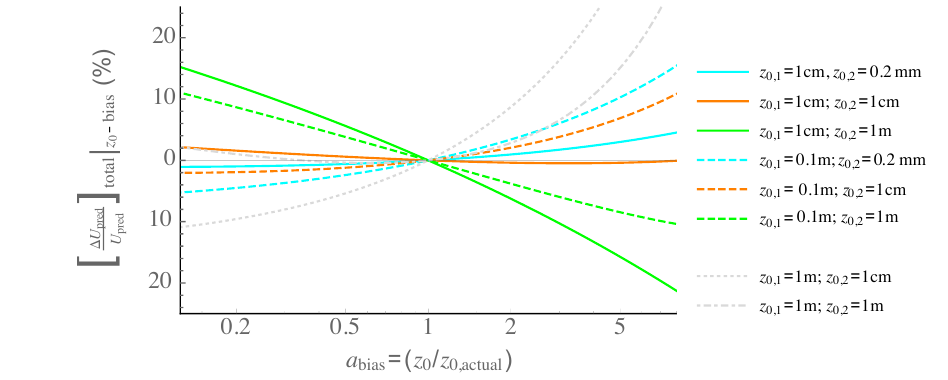
Figure 5. Total error in predicted wind speed due to a bias ( a bias ) in background roughness at both prediction and measurement sites for different combinations of background roughness at the sites. As in Figs. 3–4, observation height is z obs = 60m and prediction (hub) height is z pred = 100m.